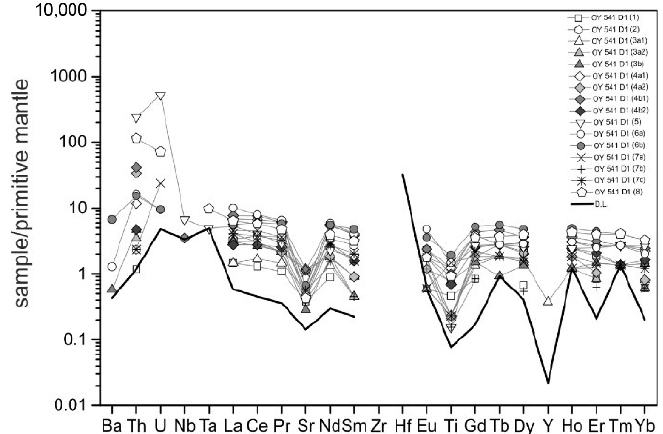
Figure 7. Multi-element diagram of trace elements (median values from LA-ICP-MS) of clinopyroxenite samples normalized against primitive mantle after McDonough and Sun [70]. D.L. = detection limit.